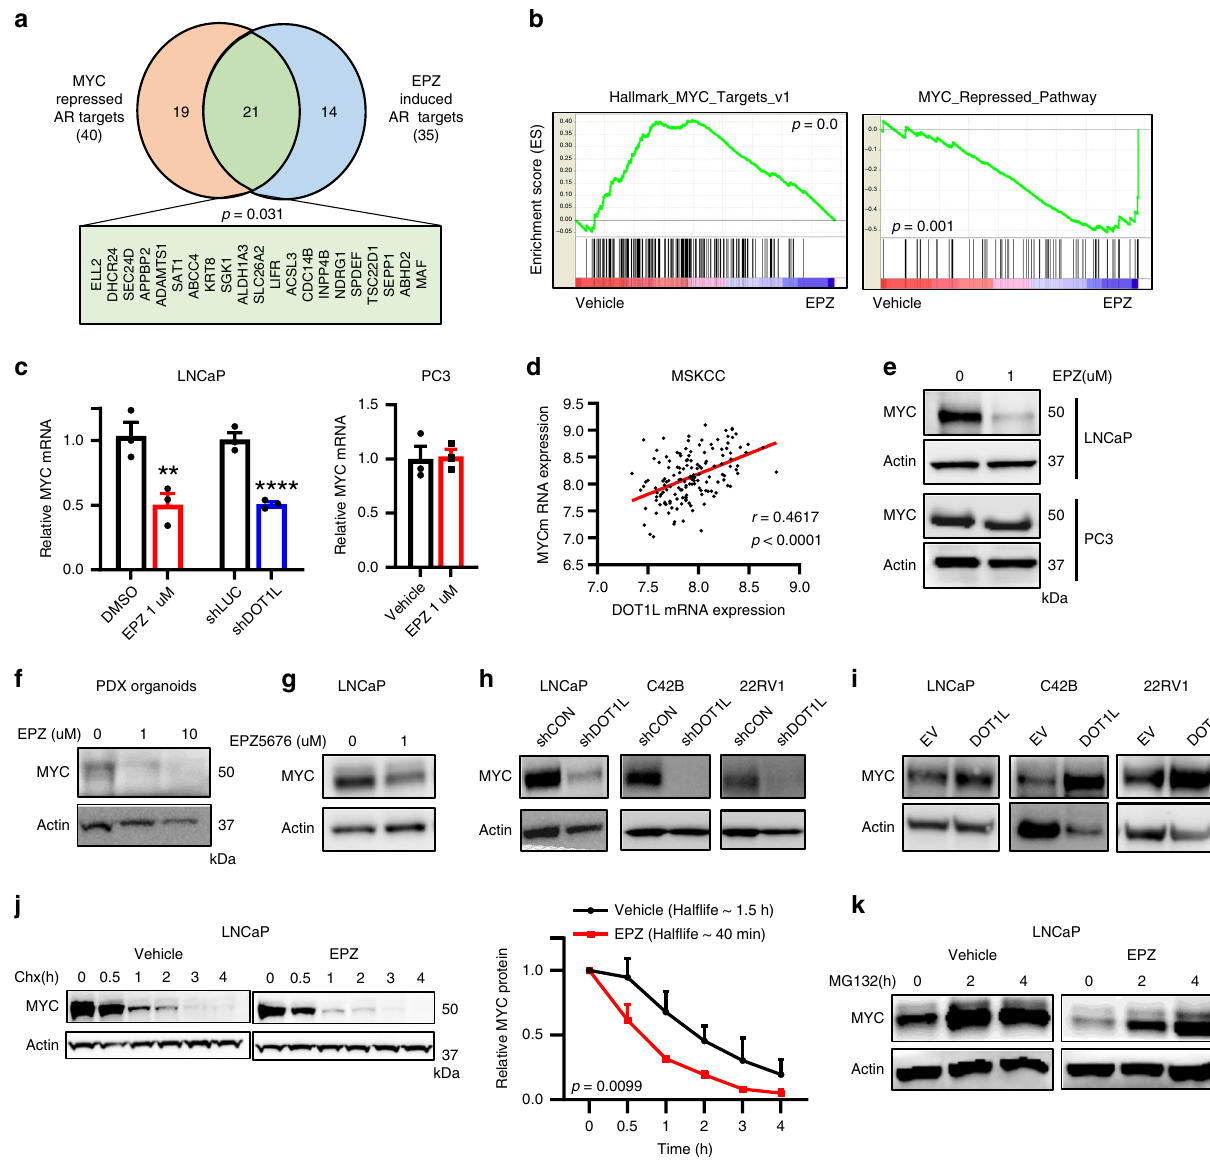
Fig. 4 DOT1L inhibition leads to impairment of MYC pathway. a Comparison of leading-edge genes from Nelson_Response_To_Androgen dataset in the present study ( n = 35) and Barfeld study ( n = 40). b GSEA plots of two MYC related datasets enriched in either Vehicle treated (left) or EPZ-treated (right) LNCaP cells. Cells were treated with 1 μ M Vehicle or EPZ for 8 days prior to microarray analysis ( n = 3). c mRNA expression of MYC in (left) LNCaP cells treated with Vehicle or 1 μ M EPZ and LNCaP cells transduced with shControl or shDOT1L lentivirus; (right) PC3 cells treated with Vehicle or 1 μ M EPZ for 8 days. d Positive correlation between DOT1L and MYC expression in the MSKCC dataset ( n = 150). Data were obtained from cbioportal.org. e Western blot analysis of MYC protein in LNCaP and PC3 cells treated with Vehicle or EPZ 1 μ M for 8 days. Representative images shown. Western blot analysis of MYC protein in ( f ) PDX organoids treated with EPZ for 8 days, g LNCaP cells treated with EPZ5676 for 8 days, h LNCaP, C42B, and 22rv1 cells with DOT1L knockdown and i LNCaP, C42B, and 22rv1 cells with DOT1L overexpression. Representative images shown. j Western blot analysis and quantitation of MYC protein after treatment with 50 ug/ml Cycloheximide in LNCaP cells treated with vehicle or 1 μ M EPZ for 8 days. k Western blot analysis of MYC protein after treatment with 10 μ M MG-132 in LNCaP cells treated with vehicle or 1 μ M EPZ for 8 days. Representative images shown. Statistical tests: p value determined by Hypergeometric test ( a ), Spearman ’ s rank correlation ( d ), and two-tailed Student ’ s t test ( c , j ). Error bars represent S.E.M. n = 3 independent experiments ( c , e – k ). ** p < 0.01; **** p < fi rst compared the leading-edge genes from the MYC repressed/ AR targets de fi ned by Barfeld with the EPZ-induced AR targets leading-edge genes from our own study and found a signi fi cant overlap ( p value = 0.03) (Fig. 4a). Examination of gene expression pro fi ling data by GSEA